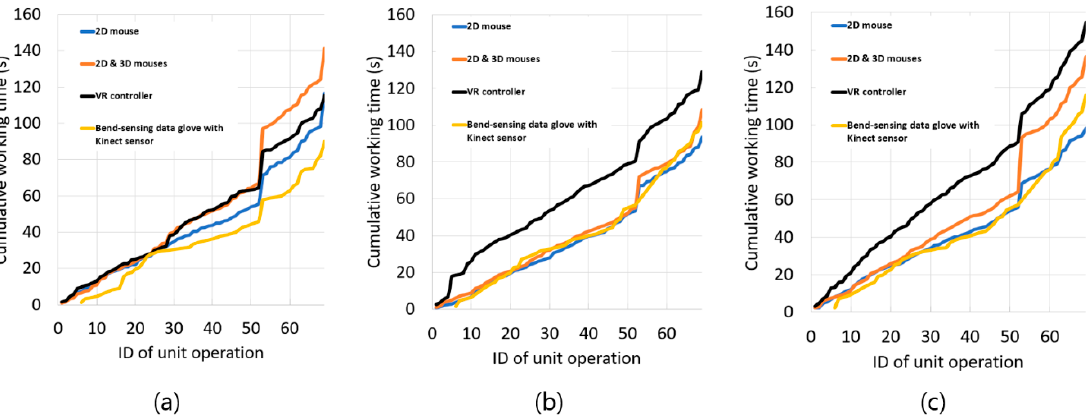
Figure 4. Cumulative working time for controlling KmodStudio in a virtual reality (VR) environment, using di ff erent user interface devices. Experimenter No. ( a ) 1, ( b ) 2, and ( c ) 3.